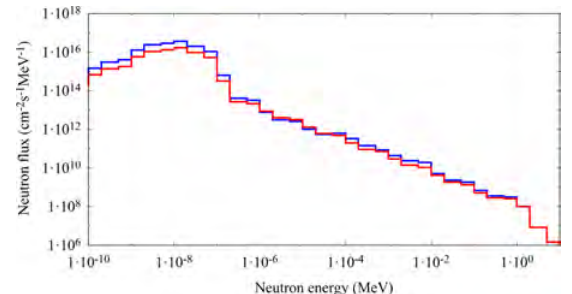
Figure 8. Comparison of analytical and unfolded spectrum.